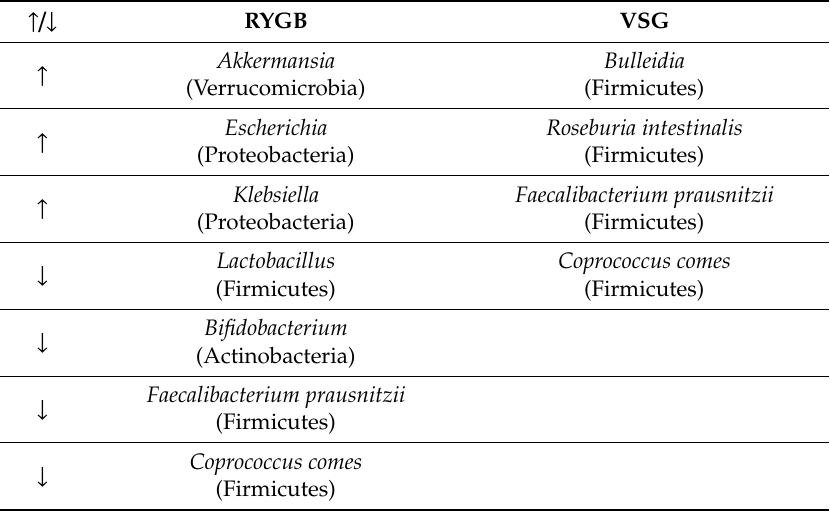
Table 2. Changes of human GM composition following BS